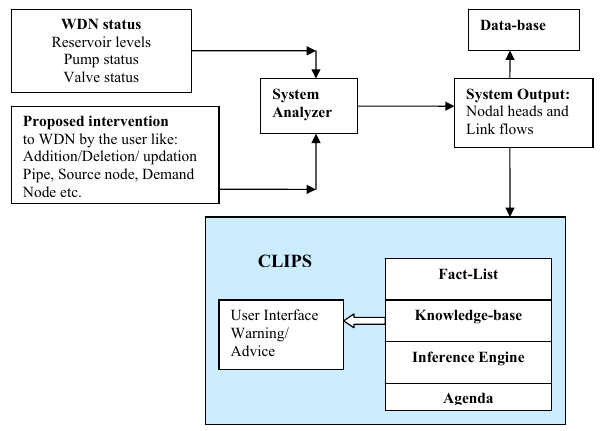
Figure 3. Components of CLIPS and its implementation in ES.